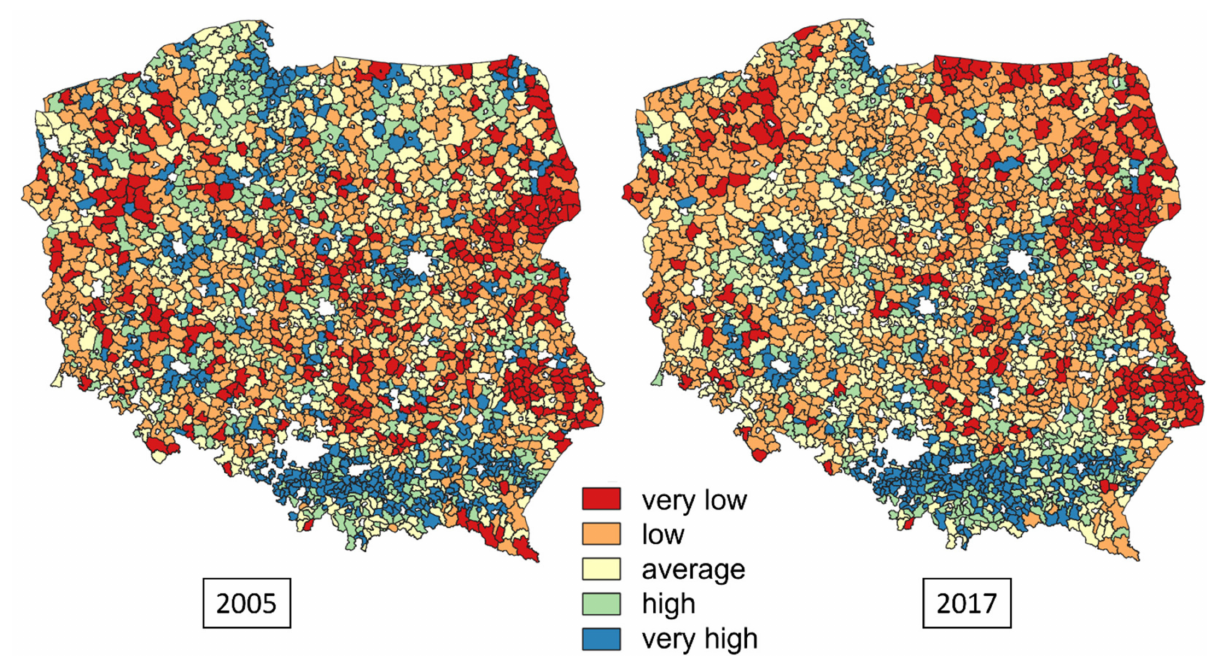
Figure 1. Cohesion index values in 2005 and 2017 spatially for municipalities in Poland for five level clusters. Source: Own